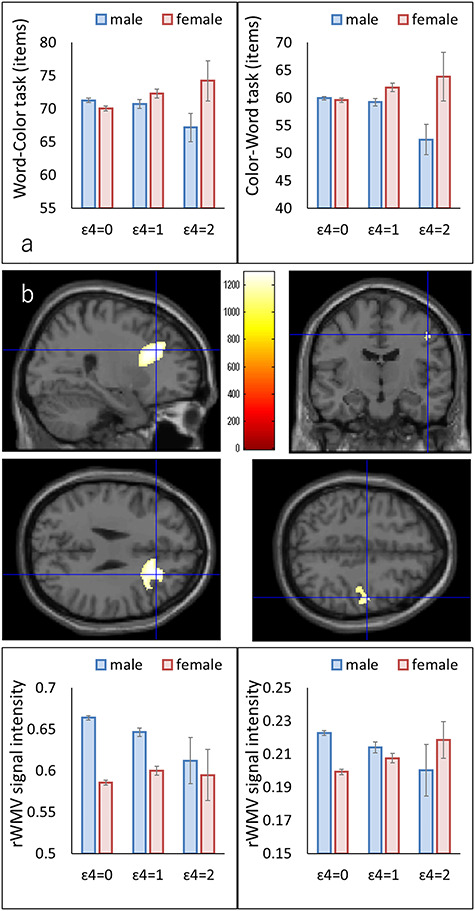

APOE ɛ4 genotype−sex interaction effects on cognitive function as well as regional brain volumes in young adults. (a) Effects on cognitive test performance. The left and right panels show the results of the Word-Color task, which is a measure of simple processing speed, and reverse Stroop task, which is a measure of executive function or inhibition, respectively. Error bars constitute the standard errors of mean. (b) Effects on rWMV. The left panels show an rWMV cluster underneath the right lateral prefrontal cortex and close to the anterior cingulate cortex, whereas the right panels show an rWMV cluster below the right precentral gyrus. The upper panels show the areas that are remarkably influenced by the APOE ɛ4 allele–sex interaction. The results were acquired using a threshold for TFCE of P < 0.05 based on 5000 permutations. Findings are overlaid on a “single-subject T1” image from SPM8. The color bar constitutes the TFCE value. The lowest two panels are the profiles of rWMV in the areas of significant clusters in both males and females of each number of the APOE ɛ4 allele.